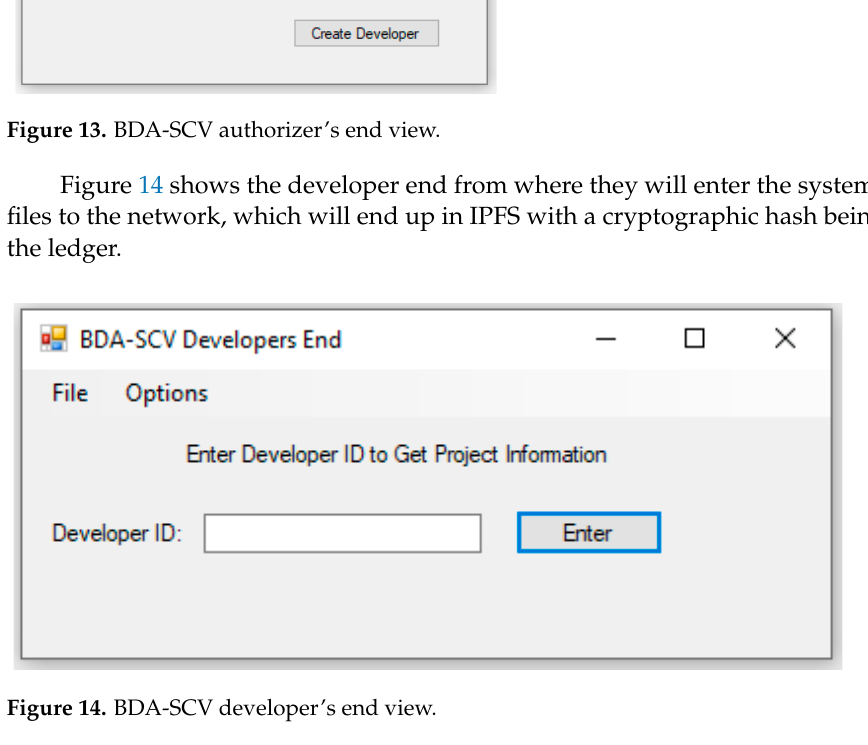
Figure 15. BDA-SCV file upload GUI. The authenticator will be responsible for creating the project in blockchain and then adding the developers to the specific project. The developer will upload document that will be created as the unique block on the blockchain, with the specific file being stored on IPFS with reference in the block data. 6. Conclusions Version control is an important part of the software development process. There is a huge amount of version control software available but most of it follows a centralized approach where a single entity can modify or tamper with the files stored. Blockchain is immutable and composed of indestructible blocks connected together by a cryptographic algorithm. Both blockchain and version control systems follow the same pattern for stor- ing block data and versioned files. In this paper we have implemented a version control system on blockchain technology, with immutability. We have also included a decentral- ized approach by using IPFS storage for the file repository. The file versions will be stored in IPFS, with the file reference being stored in blockchain data. It is not possible to store